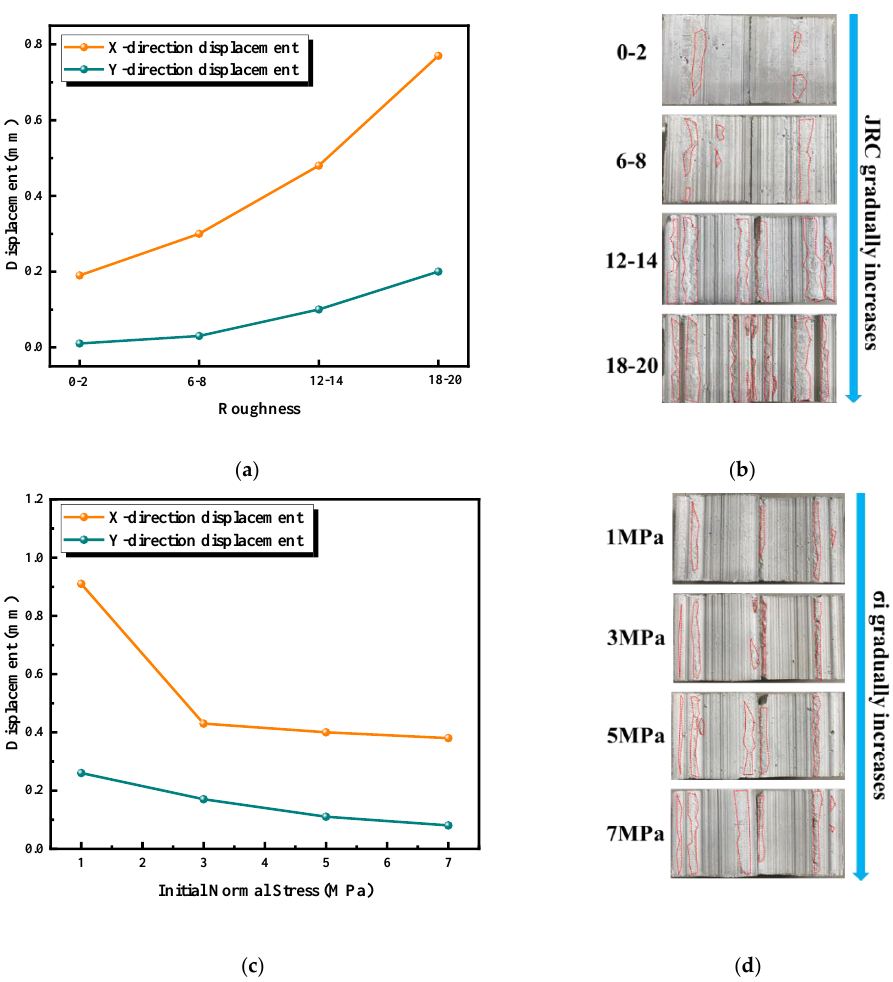
Figure 11. Relative displacements in the X and Y directions of different initial normal stress and roughness. ( a ) Relative displacements in the X and Y directions under different roughness conditions. ( b ) Wear condition of the joint. ( c ) Relative displacements in the X and Y directions of different initial normal stresses. ( d ) Wear condition of the joint.